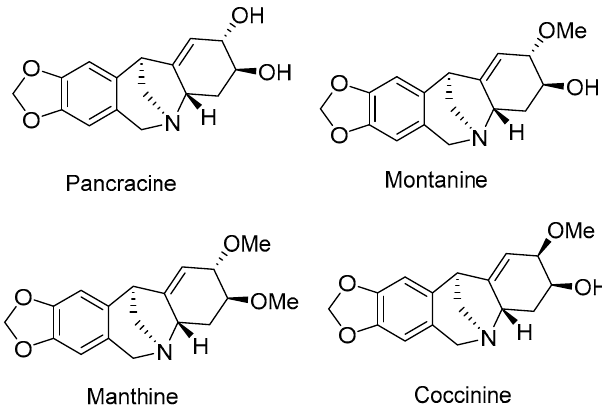
Figure 3. Structures of selected montanine-type Amaryllidaceae alkaloids.